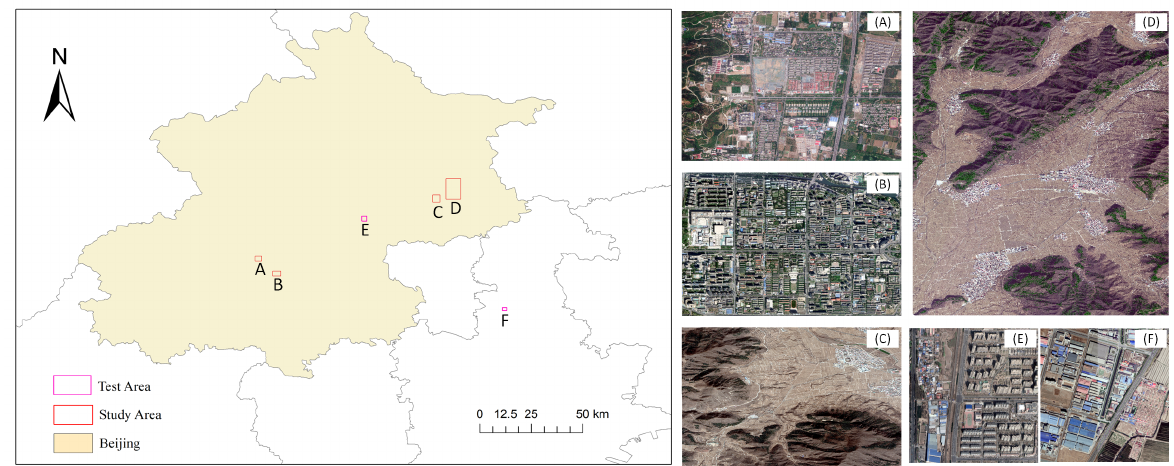
Figure 4. The locations of the Beijing buildings training dataset and test dataset. ( A – F ) represents the training and testing area used in the construction of BJ